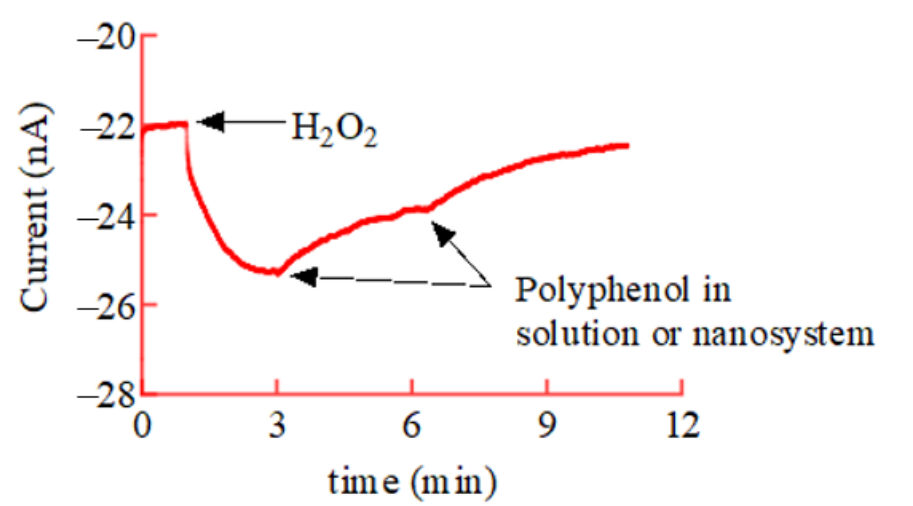
Figure 8. Relative amperometric current response of SCOE dipped in citrate buffer saline, pH 5.5.